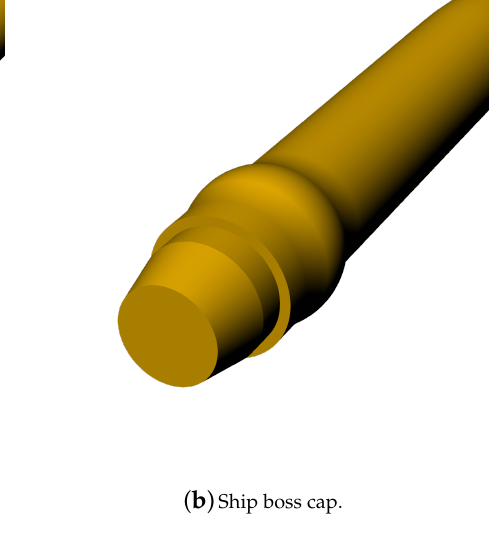
Figure 8. Numerically tested hub shapes.